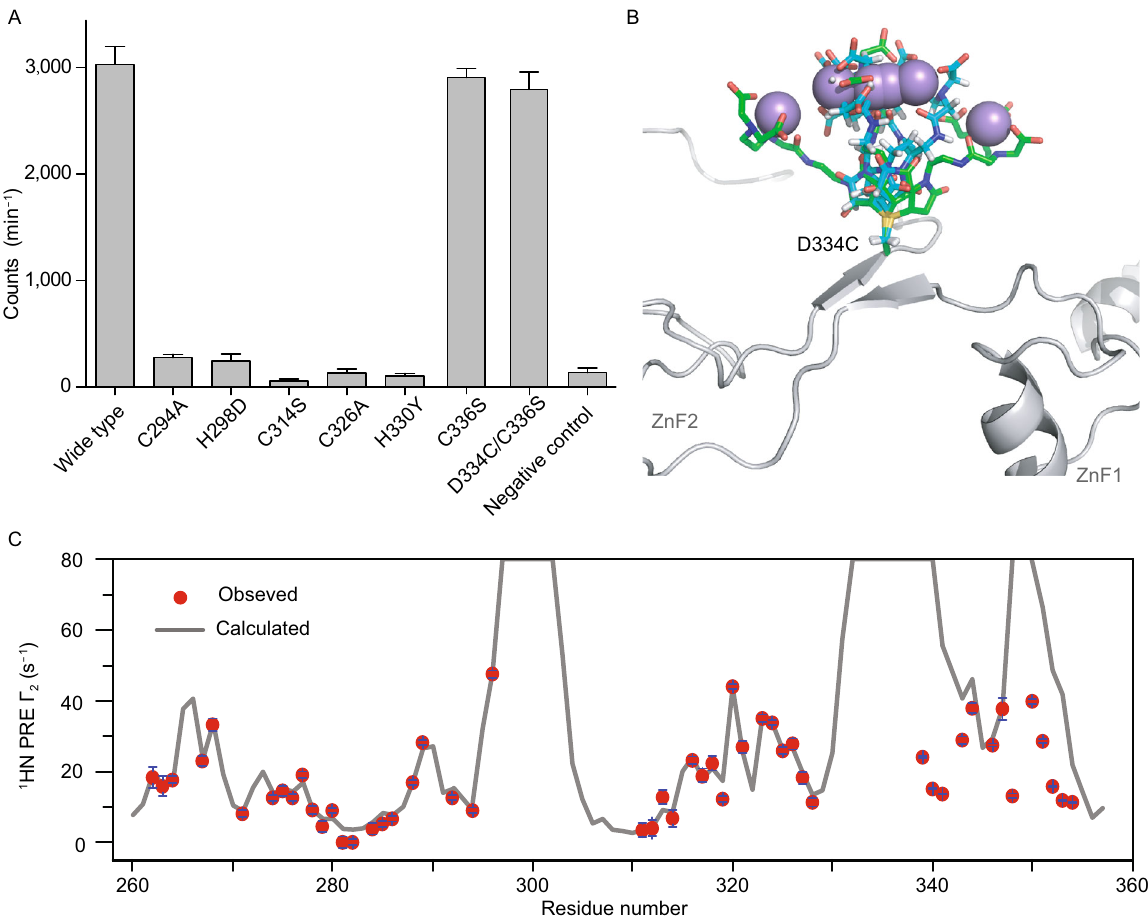
Figure 3. Structure analysis of METTL3 ZFD. (A) Point mutations introduced to the Zn 2+ -coordinating residues render the METTL3-METTL14 methyltransferase inactive. In comparison, mutation to the non-essential cysteine C336 has no effect. C314S and H330Y mutations have been identi fi ed in cancer patients. The average counts per minute (±SD with n = 3) are reported. (B) Paramagnetic probe maleimide-EDTA-Mn 2+ conjugated at D334C site of the ZFD. The probe is represented with 6 conformers shown as green and cyan sticks, 3 for each con fi guration upon Michael addition, respectively. The conformers are optimized with torsion angle dynamics during protein structure re fi nement. The metal ions are shown as spheres. (C) The PRE measurement provides long-range structural constraints. The observed values are shown as red circles, with the error bars denoting the SD from measurement uncertainties. The back-calculated values from the fi nal structure closest-to-mean are shown as black